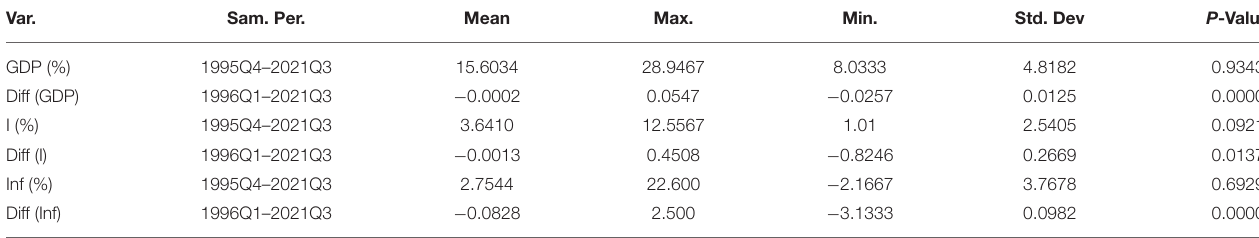
TABLE 1 | Statistical description of the main variables in the article. Var. Sam.